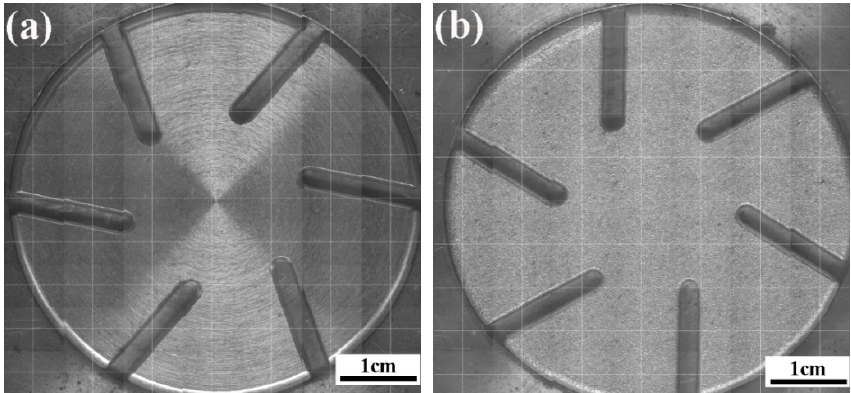
Figure 8. Top-view of ( a ) untreated and ( b ) LSM-treated Cu-50Cr contacts.